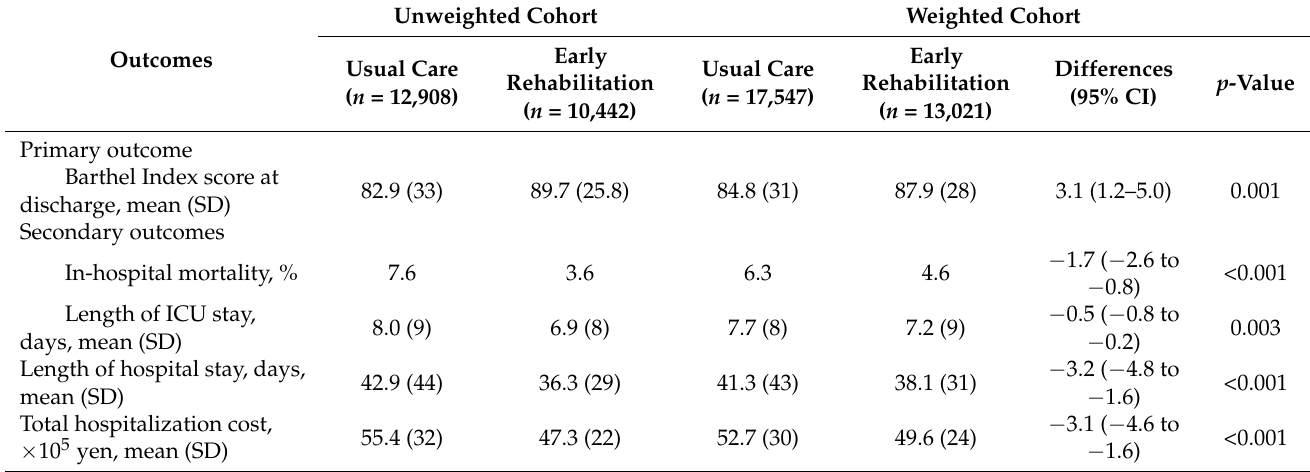
Table 3. Results of the complete case